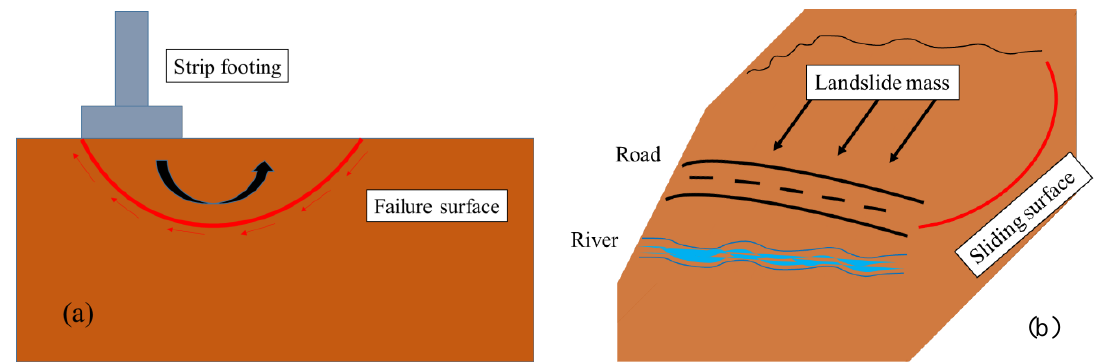
Figure 1. Failure mechanism of ( a ) Bearing capacity failure, and ( b ) Slope failure example.